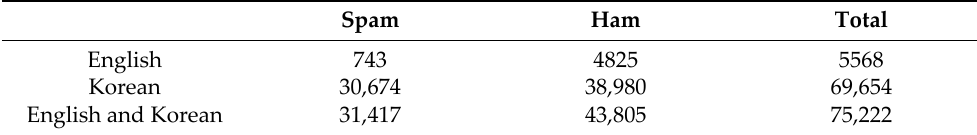
Table 2. Dataset matrix.